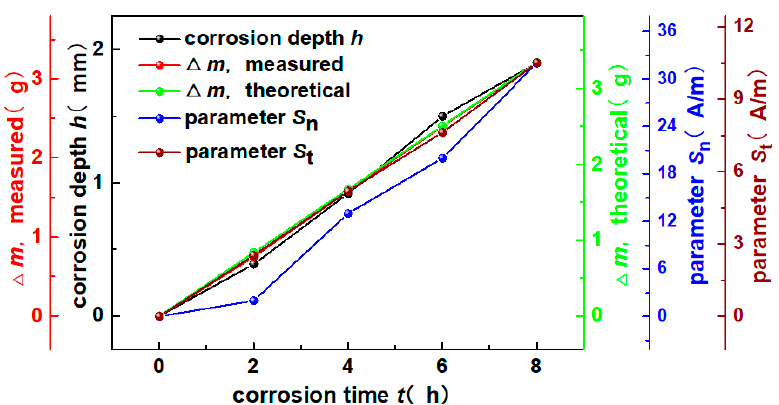
Figure 14. Variations of characteristic magnetic parameters ( S n and S t ), mass loss of the specimen ( △ m , measured and △ m , theoretical), and defect feature (corrosion depth h ) with corrosion time ( t ).